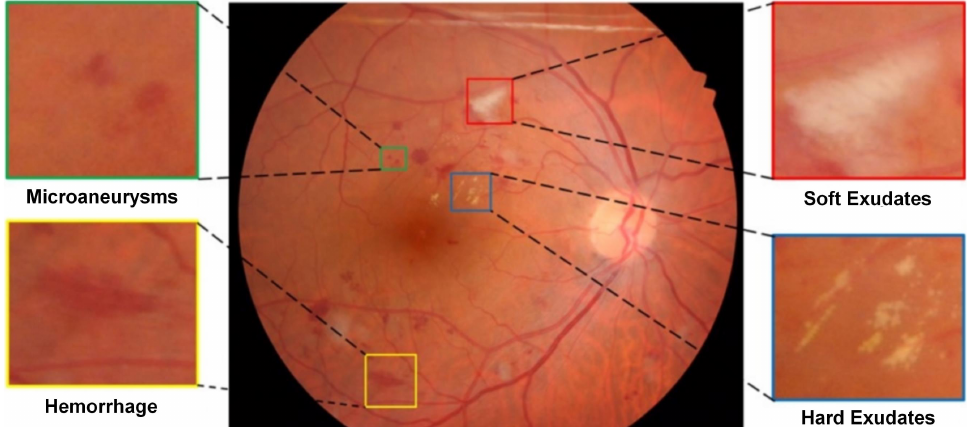
Figure 2. Representation of fundus image with the lesions annotated: Microaneurysms, Hemorrhages, Soft Exudates, and Hard Exudates.